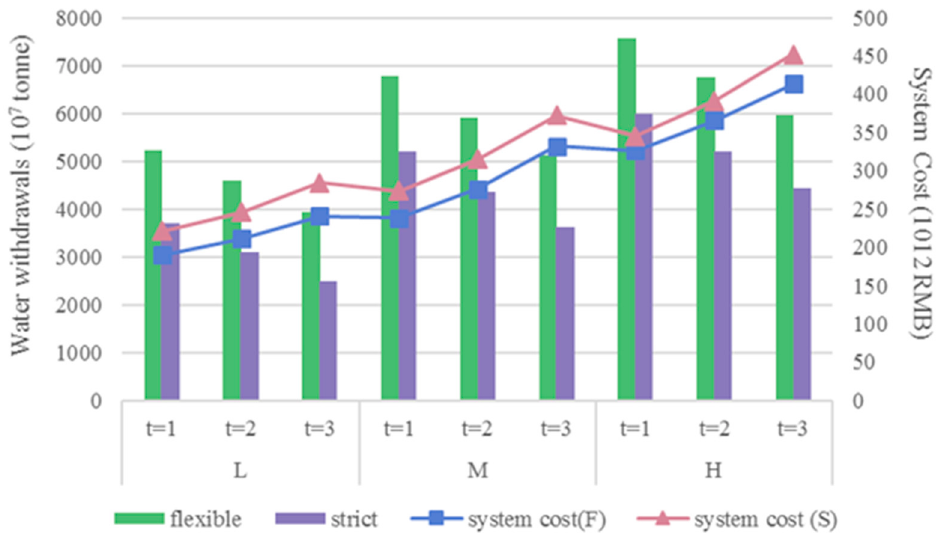
Figure 9. The water withdrawals and system cost.